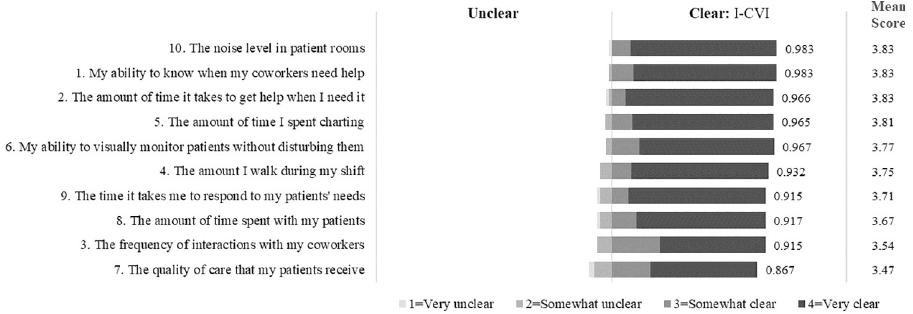
Fig 5. Phase 2 clarity of CARE items response. Frequency, clarity I-CVI, and mean score response.